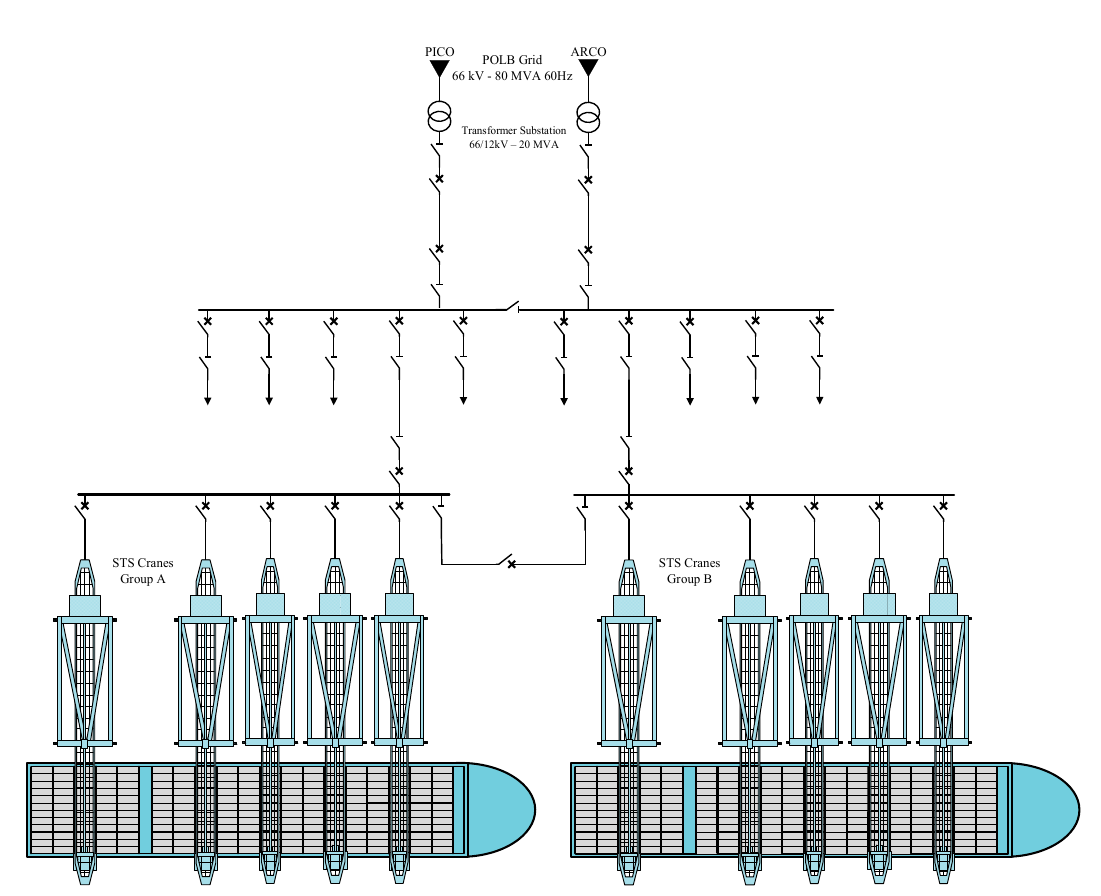
Figure 4. One-line diagram for STS cranes Power Supply.